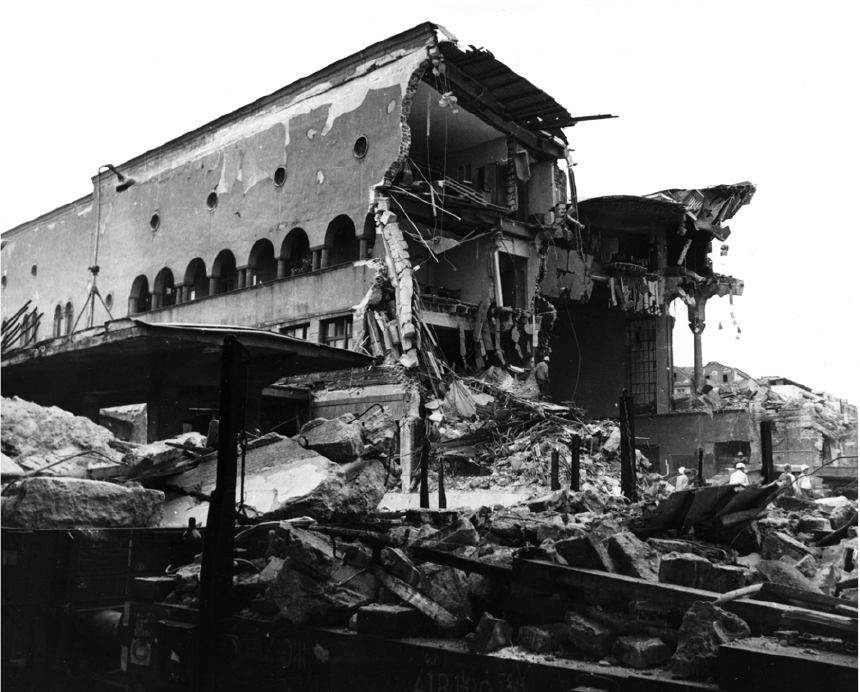
Fig. 1 Skopje earthquake: The Rail- way Station (Source: Museum of the City of